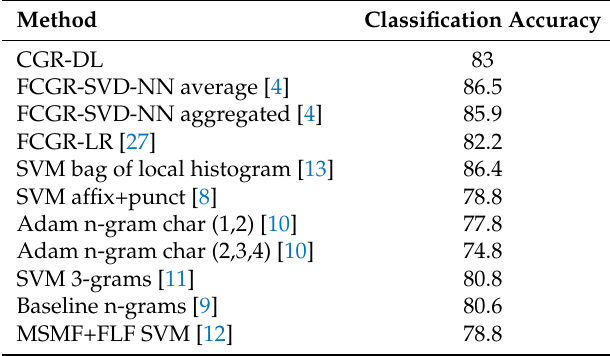
Table 2. Results of the proposed technique and of other methods on the CCAT10 benchmark data